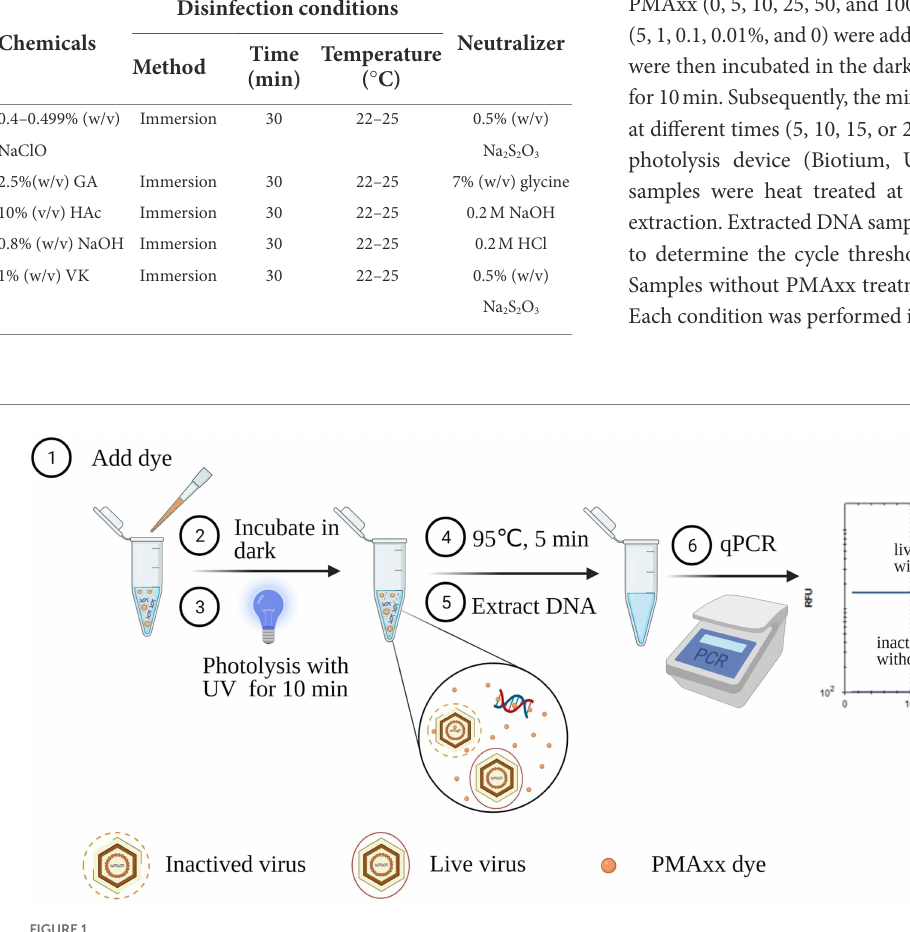
FIGURE 1 Schematic diagram of the PMAxx-qPCR assay for discriminating infectious and inactivated ASFV. The schematic was produced on https://